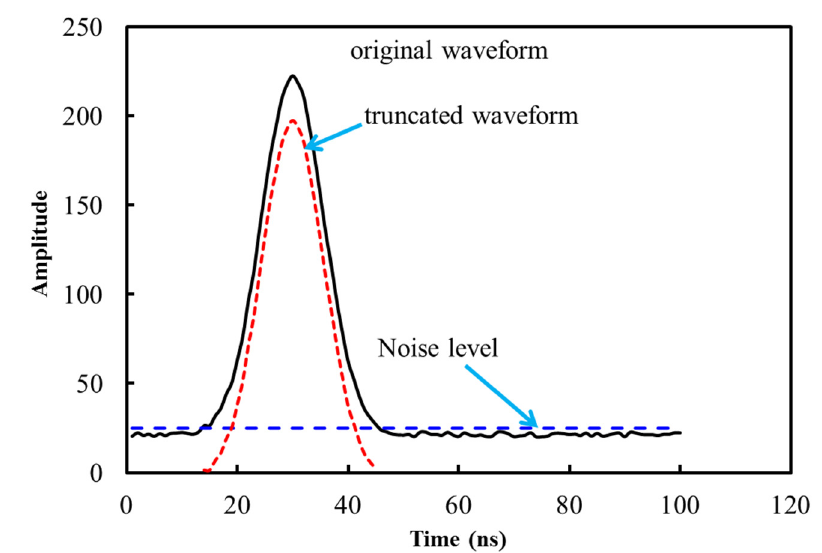
Figure 1. Pre-processing of the return waveform by removing data below the noise threshold of the original waveform. The noise level is defined as 10% above the return gate which is given by the manufacturer specifications. The truncated waveform is saved for posterior